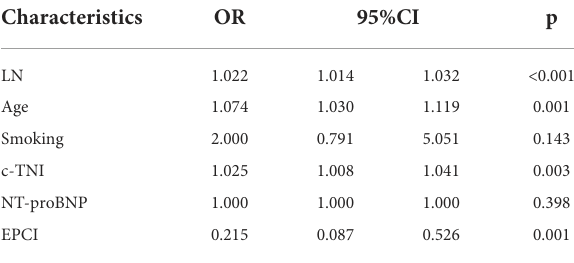
TABLE 2 Binary logistic regression analysis of independent predictors of